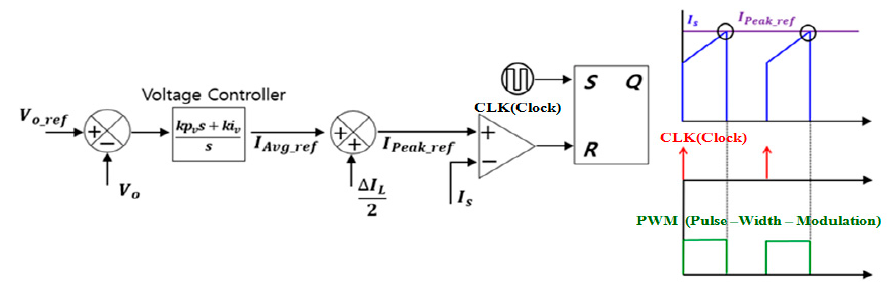
Figure 2. Operation principle of peak current mode control.